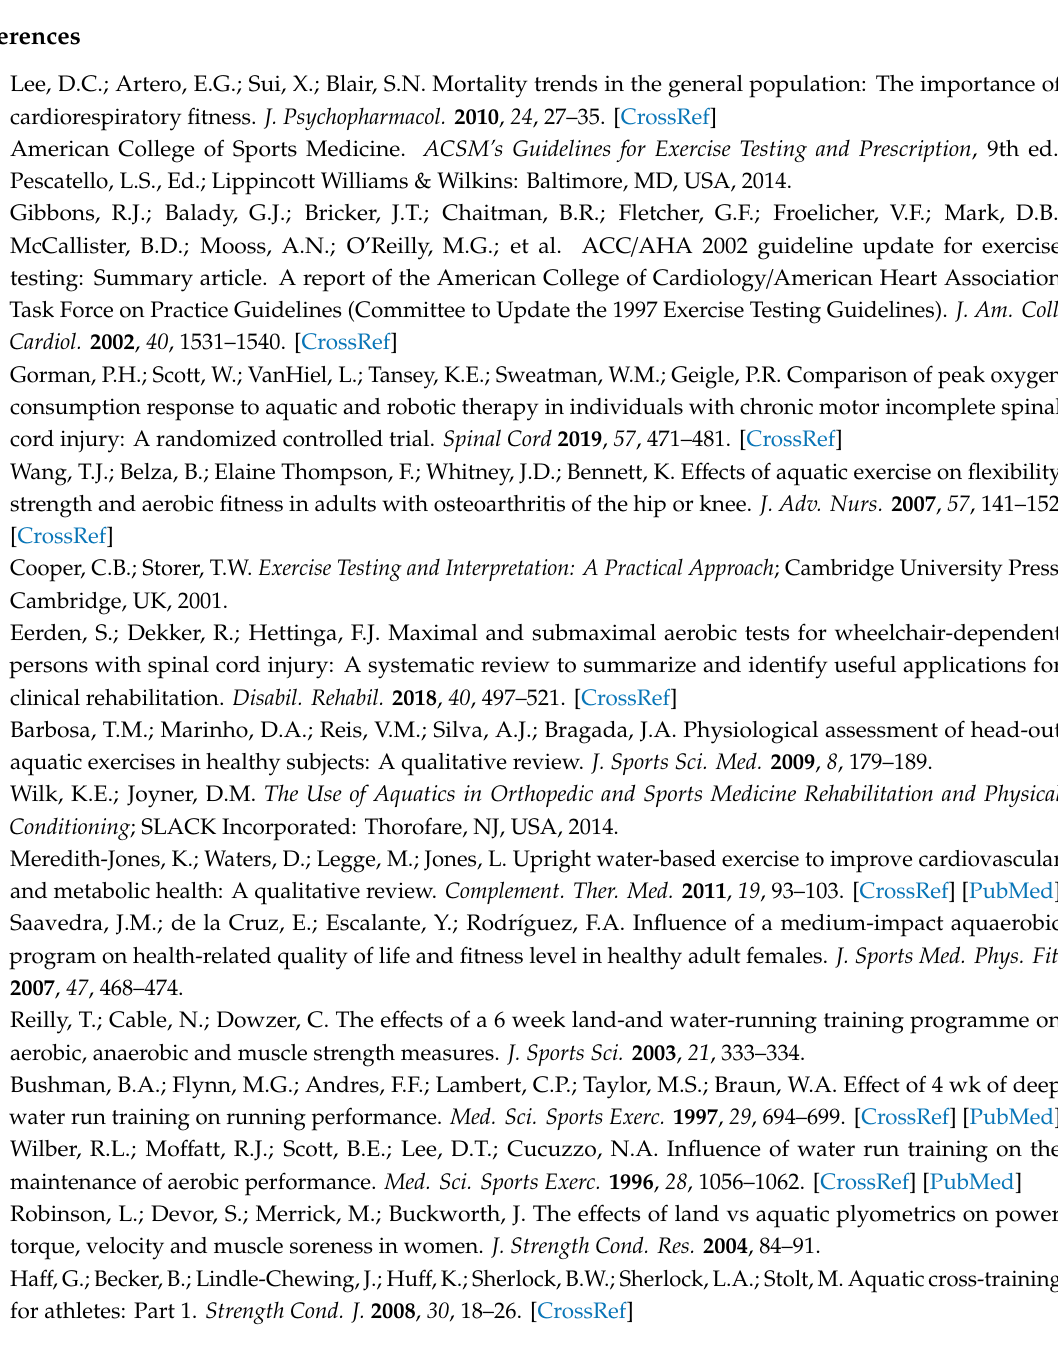
Table S1: Example of search parameters, Table S2: Quality assessment of included